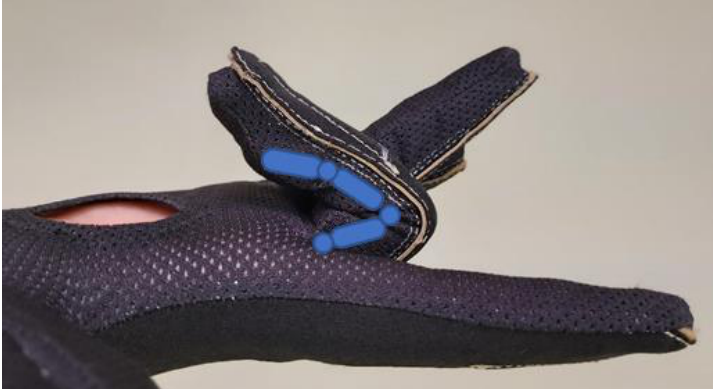
Figure 8. Middle finger DIP (represented in blue) flexed without bending the corresponding gauge. The boxplot of all the angles recorded while performing the SHFT is presented in Figure 9, along with subjects’ hand size. This evidenced that the recorded angles were not affected by hand size when it was longer than 184 mm and the glove properly fitted.